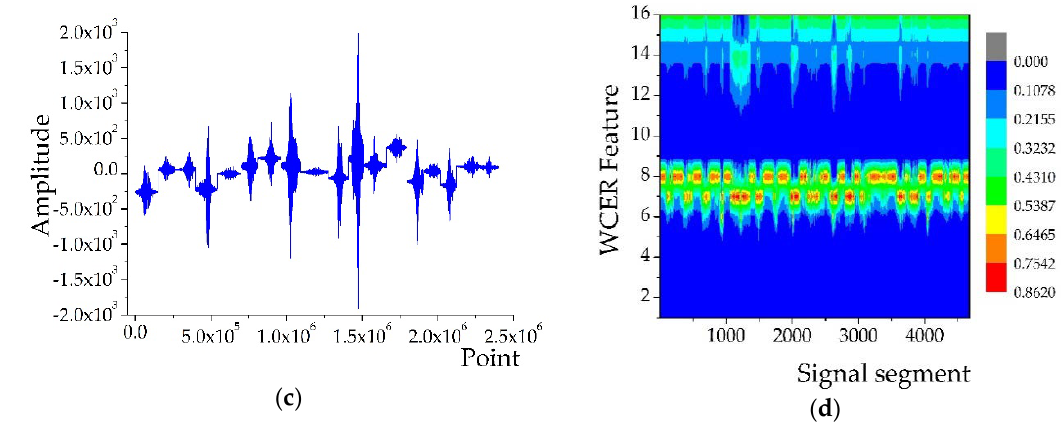
Figure 3. WCER features of AAV3 signals: ( a ) Acoustic signal of AAV3 acquired from 18 sensor nodes; ( b ) features extracted from the acoustic signal of AAV3; ( c ) seismic signal of AAV3 acquired from 18 sensor nodes; and ( d ) features extracted from the seismic signal of AAV3.